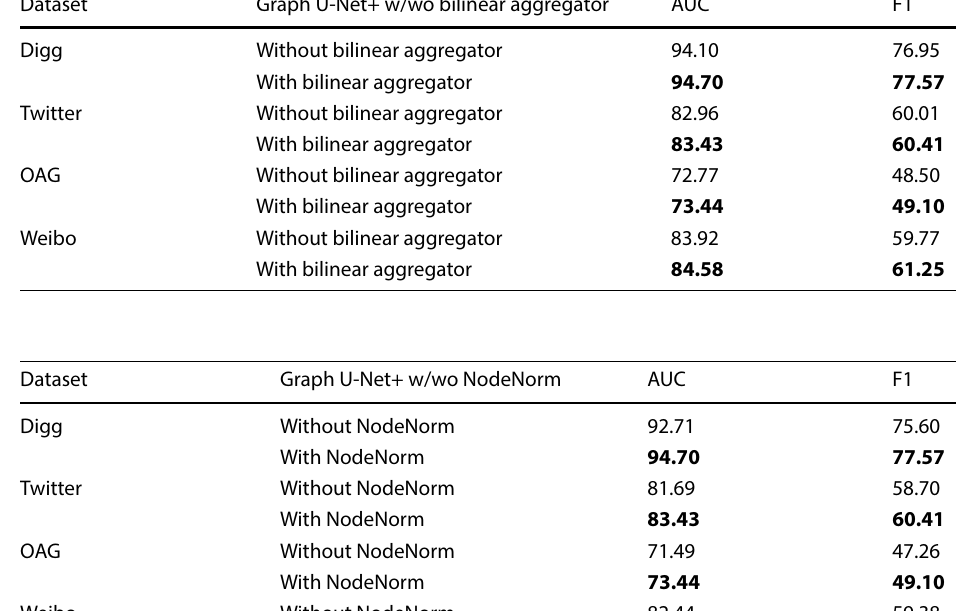
Table 6 Social behavior prediction performance of graph U-Net+ with or without node bilinear information aggregator on AUC and F1 metrics ( % )